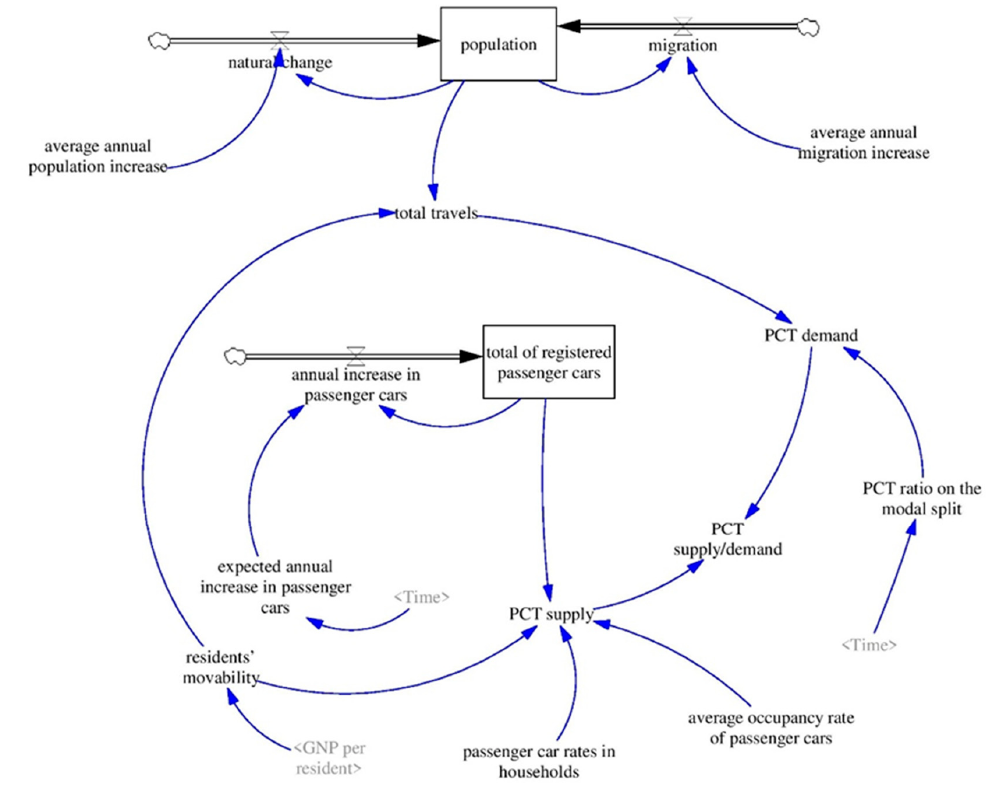
Figure 2. Supply and demand estimation model in CT and PT–first part of the model (source: Au- thors).